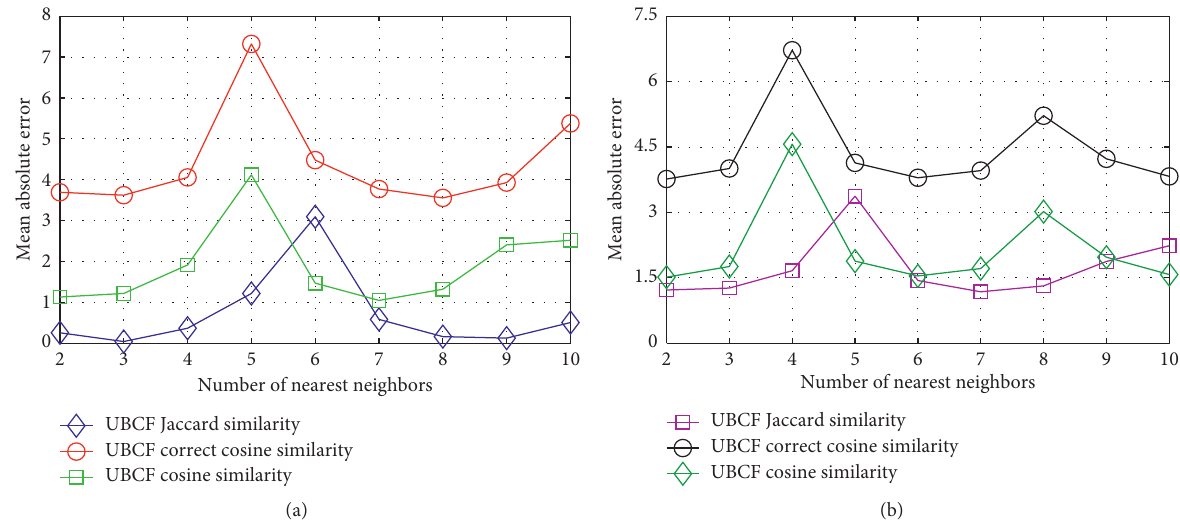
Figure 8: Experimental results of MAE based on the traditional UBCF algorithm under different similarity indicators. (a) Test result of the first user. (b) Test result of the second